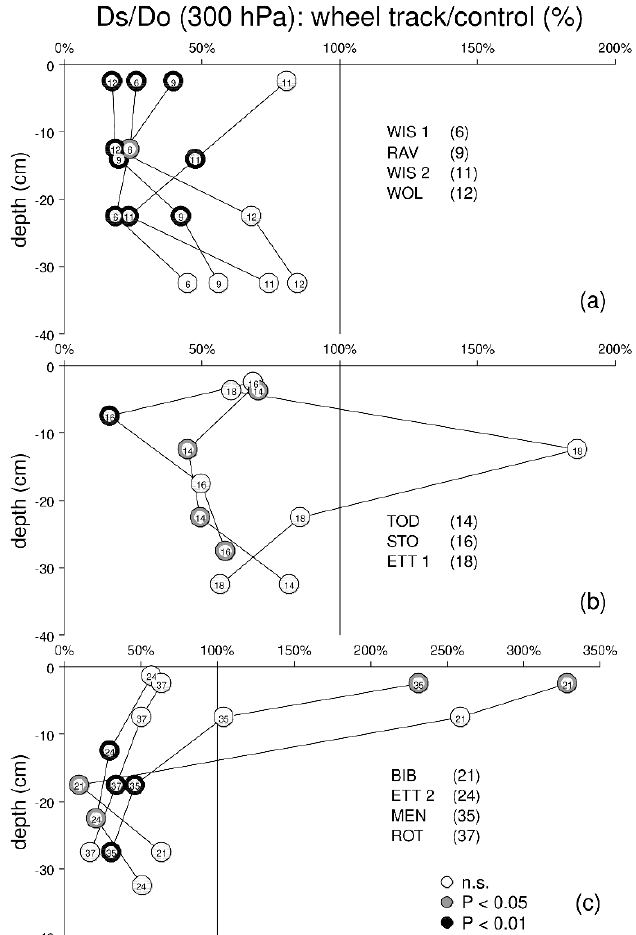
Figure 6. Ratios of relative apparent diffusion coefficients D s /D o measured at − 300 hPa (wheel track/control x 100) for sites with ( a ) recovery time of up to 12 years, ( b ) recovery time from 12 to 18 years, and ( c ) recovery time from 21 to 37 years. The significance levels of the pairwise Wilcoxon rank test are highlighted by differing grey shading intensities ( p < 0.01, p < 0.05, and ⃝ = not significant).